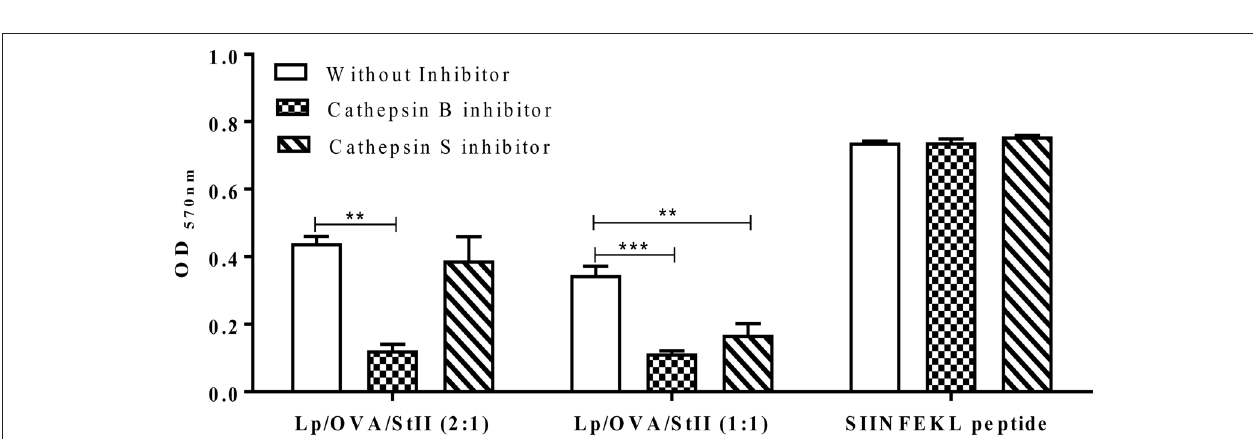
FIGURE 5 | Cathepsin B and S differentially affect antigen cross-presentation induced by StII co-encapsulated with OVA into liposomes containing different quantities of Chol . Bone marrow-derived macrophages (BM-M 8 s) from C57BL/6 mice were pre-incubated or not with 10 µ M cathepsin B or cathepsin S inhibitors and stimulated with OVA co-encapsulated with StII into liposomes composed by DPPC and Chol in 2:1 or 1:1 ratios [Lp/OVA/StII (2:1) or Lp/OVA/StII (1:1)] at final concentrations of 0.8 µ g/ml and 0.1 µ g/ml of each protein, respectively. Cells stimulated with 10nM of the SIINFEKL peptide were used as experimental controls. After stimulation cells were washed and co-cultured with B3Z CD8 + T cells. β -galactosidase activity of the B3Z cells was measured by a colorimetric assay. Mean ± SEM of OD 570nm of two independent experiments are shown. Statistical analysis was performed with one-way ANOVA test with Dunnett post-test: ** p < 0.01, *** p <